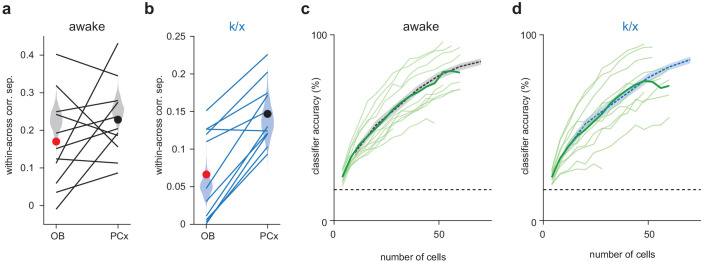
Similar outcomes for simultaneously recorded PCx populations and pseudopopulations.(a–b) Within-across odor population vector correlation difference for awake trials (a) or k/x trials (b) in OB and PCx. Each line is a separate simultaneous OB-PCx recording (n = 11). Circles show means for OB (red) and PCx (black). Pseudopopulation correlations measures from Figure 1 are shown as shaded violin plots for comparison. (c–d) Classifier accuracy for simultaneously recorded PCx populations up to 60 cells in awake (c) or k/x trials (d). Each light green line is a separate PCx recording. The average accuracy across recordings is shown as a bold green line. Classifier performance from Figure 1 is shown as a dashed line for comparison.